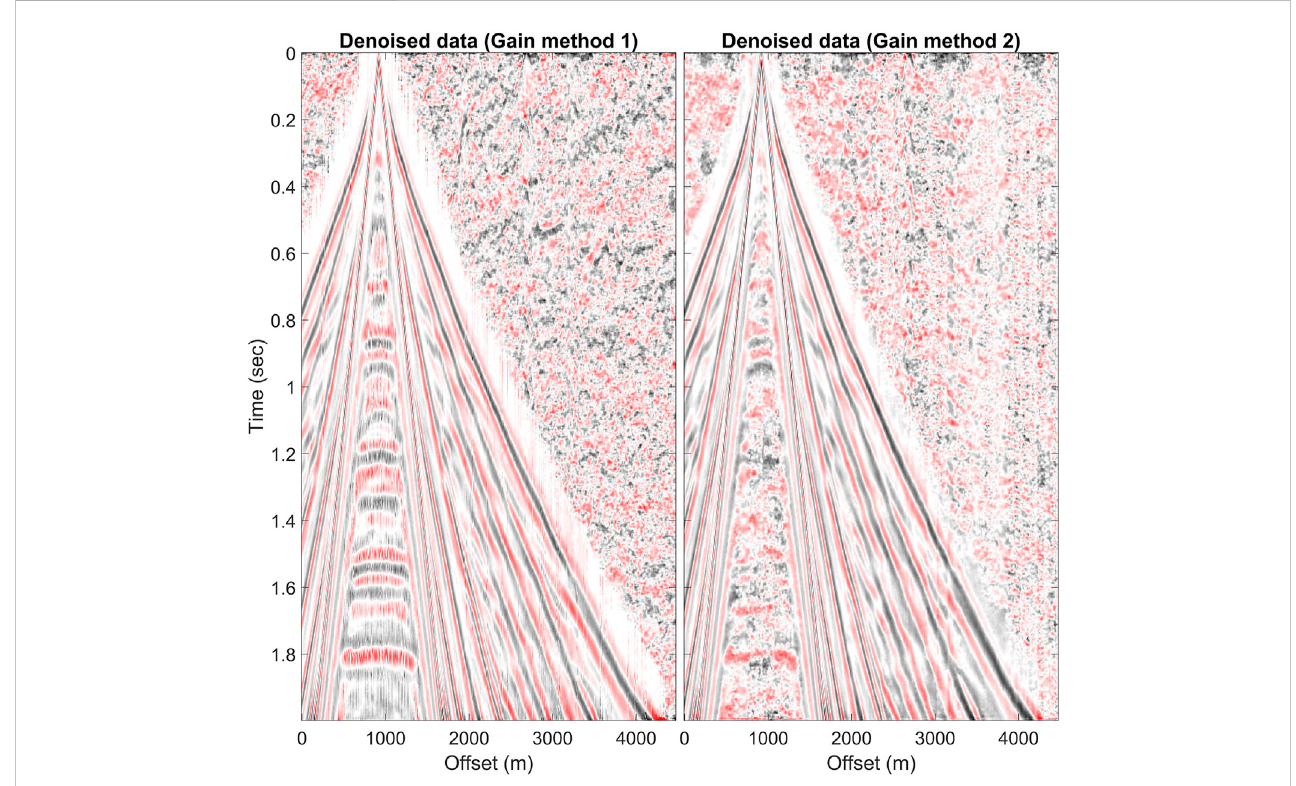
FIGURE 4 Denoising comparison of two gain methods. Images are applied using the AGC. The results using method 1 (the AGC) have an RMSE of 0.09 and those using method 2 (the 2D AGC) have an RMSE of